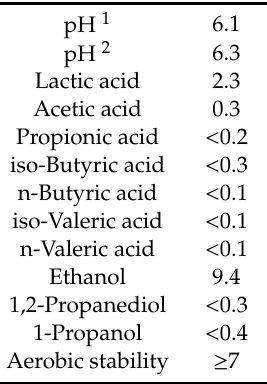
Table 1. Fermentation characteristics of the field pea grain